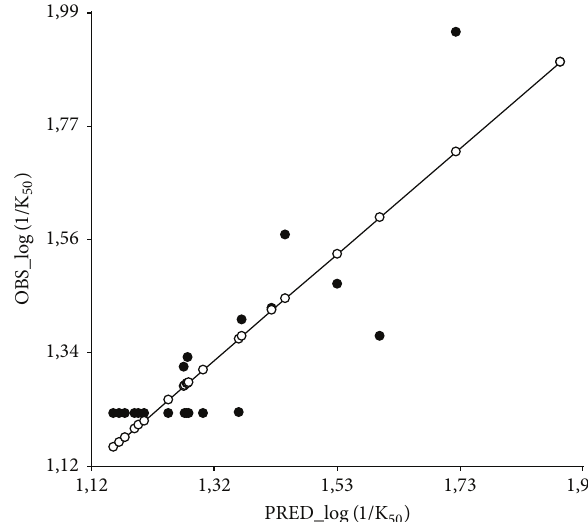
Figure 1: Multiple linear regression analysis (MLR) calculated to examine quantitative relationships between linear combinations of the dependent variable log (1/KT 50 ) and the predictor variables (structure and molecular properties). Plot of calculated versus experimental log (1/KT 50 ) of fumigant activity of oxygenated ter- penes against lice.